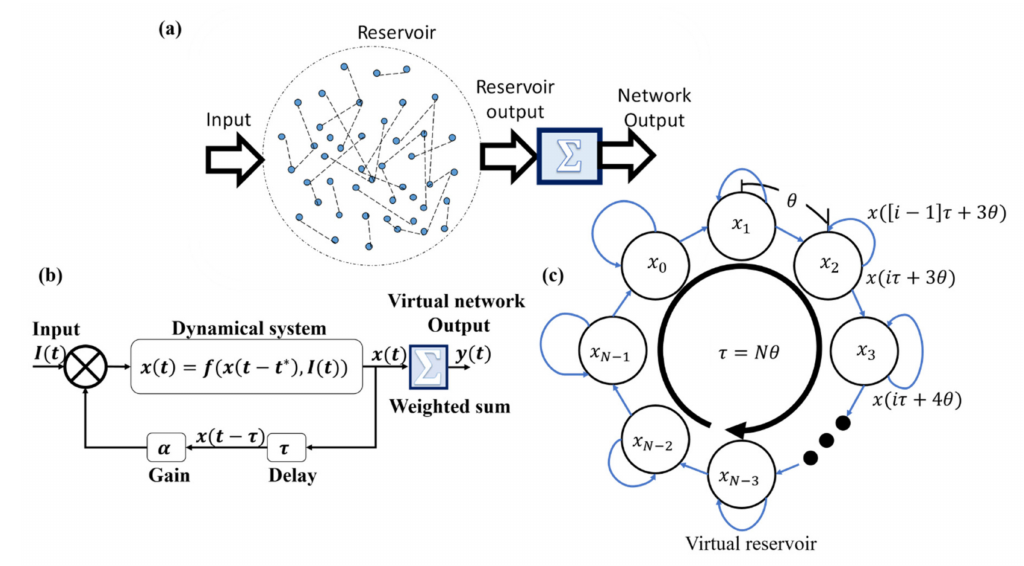
Figure 1. Reservoir computing (RC) schemes. ( a ) Classical RC utilizes a large network of randomly connected neurons. The output of the reservoir is a simple weighted sum of the neuronal response. ( b ) Delay-based RC utilizes the properties of dynamical systems and delayed feedback. ( c ) The virtual reservoir produced from delayed feedback and system